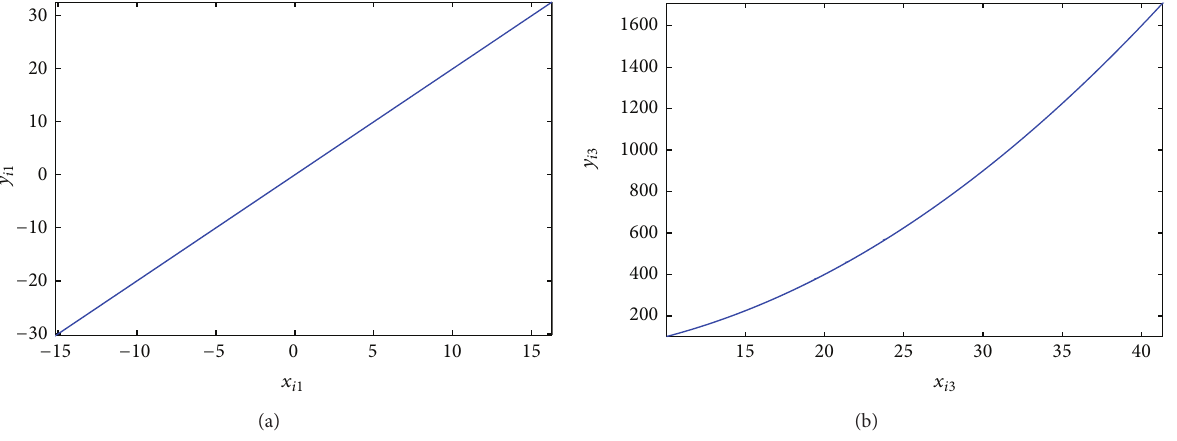
Figure 6: Relationships between the subvariables for node 3 in the drive and response network. Left: 𝑦 𝑖1 = 2𝑥 𝑖1 ; right: 𝑦 𝑖3 = 𝑥 2 𝑖3 . network (15) reach complete outer synchronization, that is, lim 𝑡→∞ ‖ z 𝑖 (𝑡) − y 𝑖 (𝑡)‖ = 0 for any initial conditions (0) ̸= z (0) (𝑖 = 1, 2, . . . , 𝑁) y 𝑖 𝑖